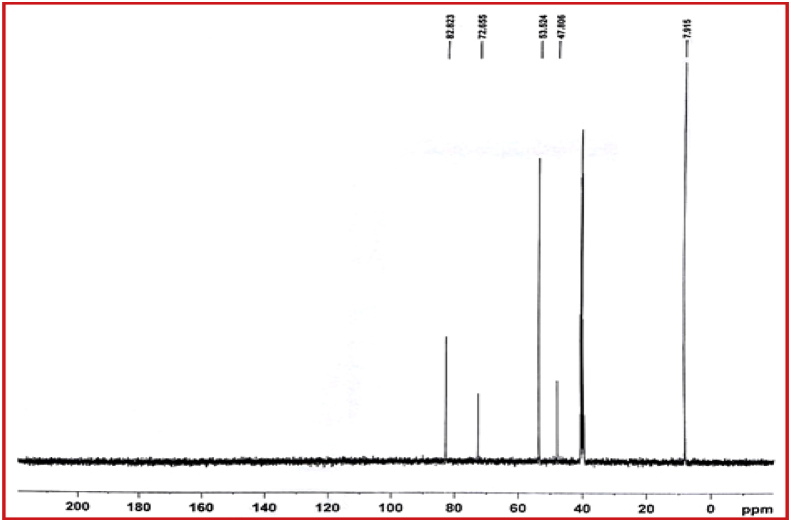
13C NMR of propargyl triethyl ammonium bromide.